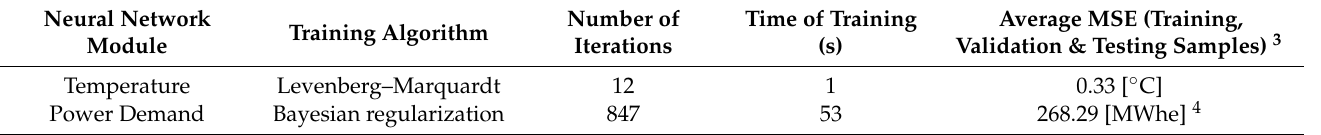
Table 5. Neural network’s training algorithm